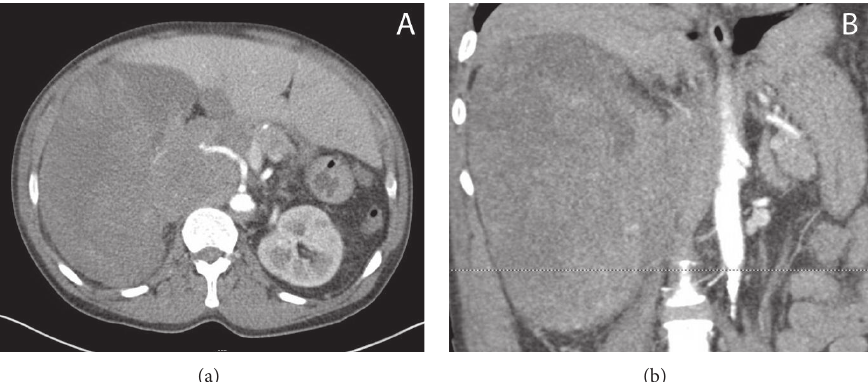
Figure 1: (a) Flow of contrast in the renal artery entering a large right-sided renal mass. (b) Large right-sided renal mass exhibiting mass effect on the aorta and other retroperitoneal structures.